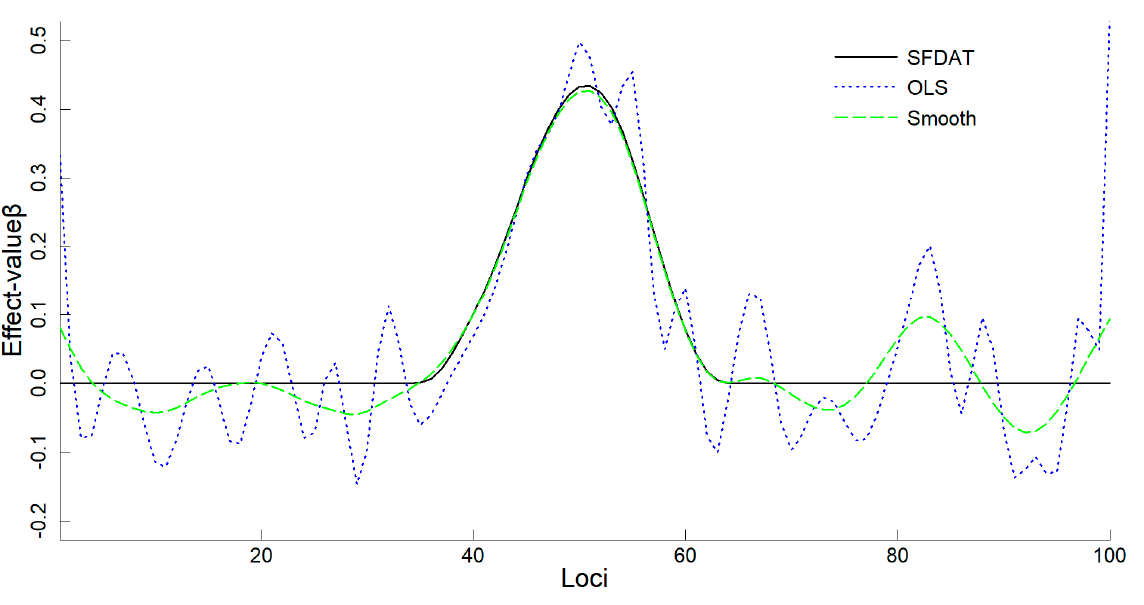
Figure 5. E ff ect functions 𝛽(cid:4632)(𝑡) estimated by SFDAT, OLS and Smooth methods. Solid line repre- Figure 5. Effect functions ˆ β ( t ) estimated by SFDAT, OLS and Smooth methods. Solid line represents sents the SFDAT, dot line represents the OLS and dashed line represents the Smooth. the SFDAT, dot line represents the OLS and dashed line represents the